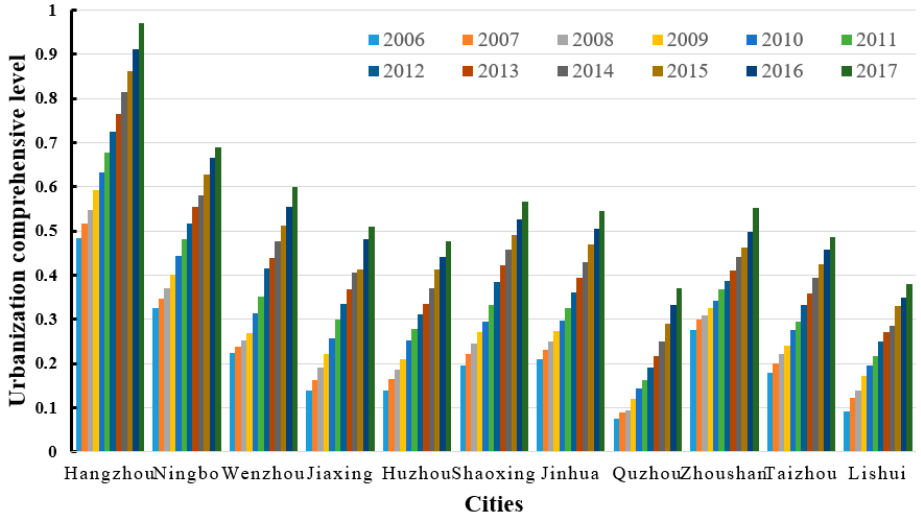
Figure 3. Trends in the urbanization system scores of 11 cities in Zhejiang.